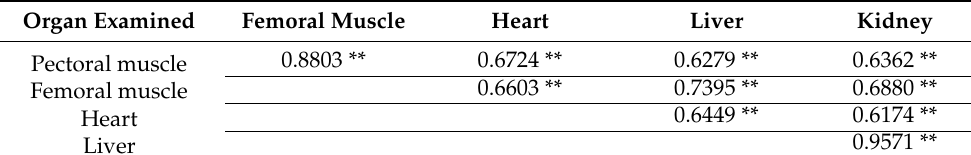
Pectoral muscle Femoral muscle Heart Table 4. Correlation coefficients between Hg concentrations in the Eurasian magpie organs ana- lyzed.